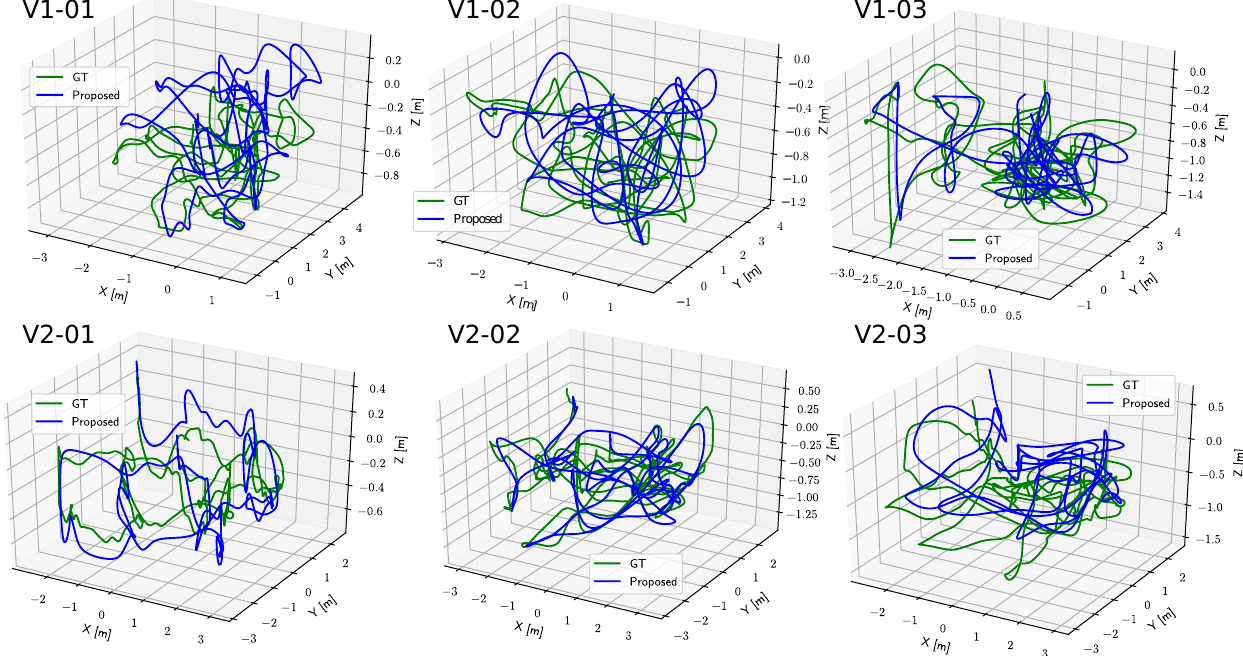
Figure 6. EuRoC 3D trajectory estimation compared to the ground truth.